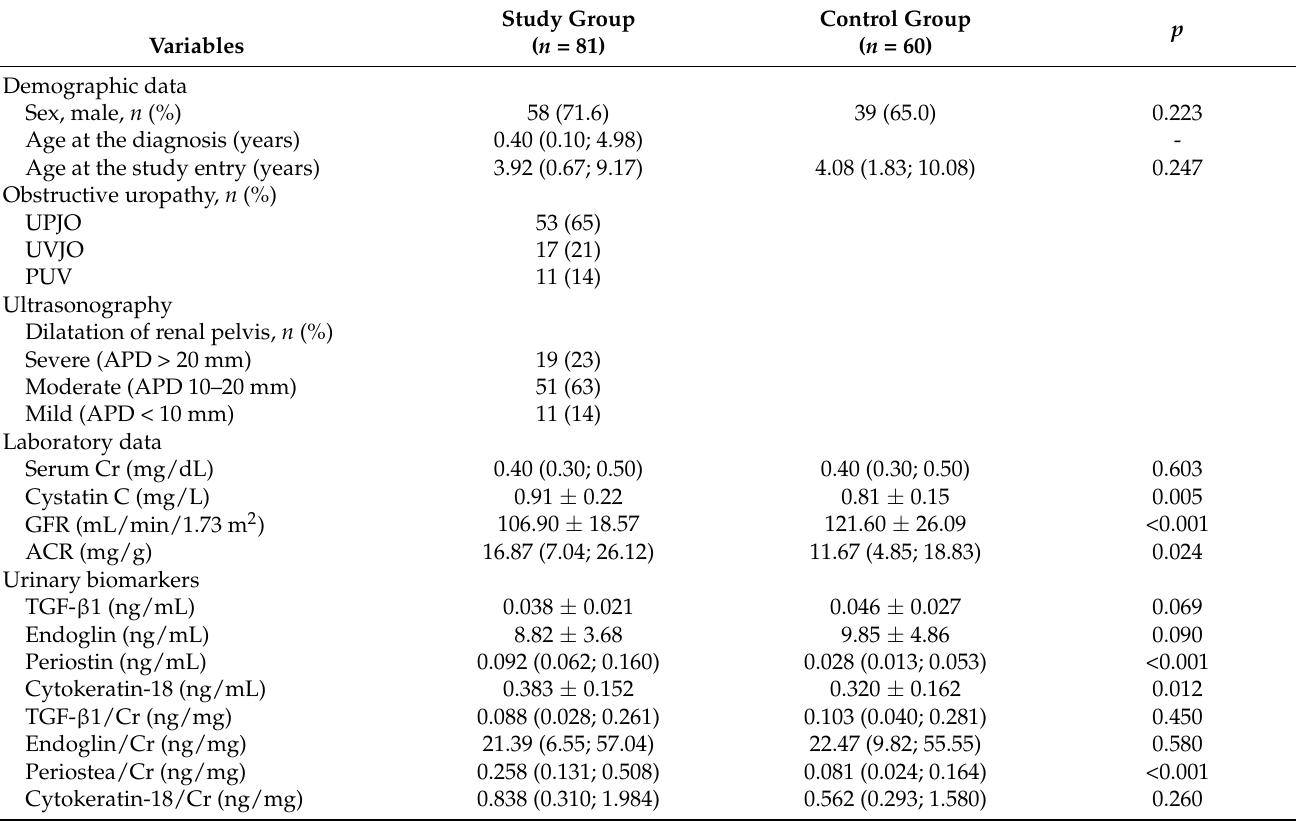
Table 1. Clinical and laboratory data in the study group and in the control group.